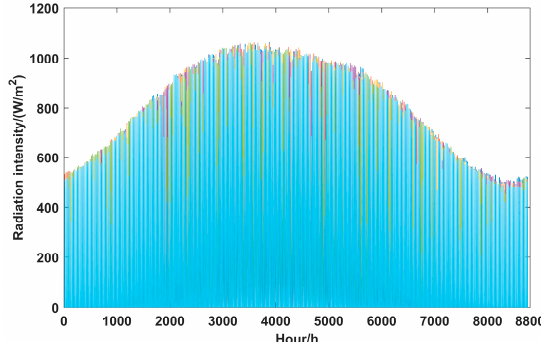
Figure A4. Measured solar radiation intensity in eastern Mongolia. Table A1. Device parameters.